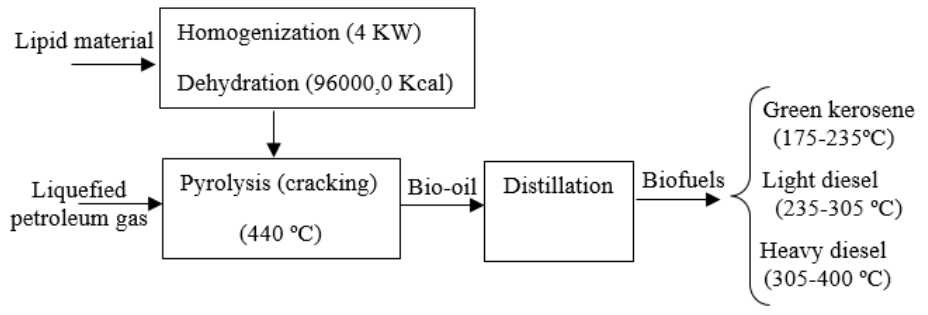
Figure 2. Scheme of conversion of lipid-based material into biofuels.